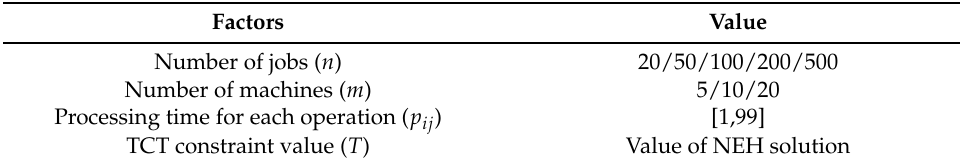
Table 1. Summary of test